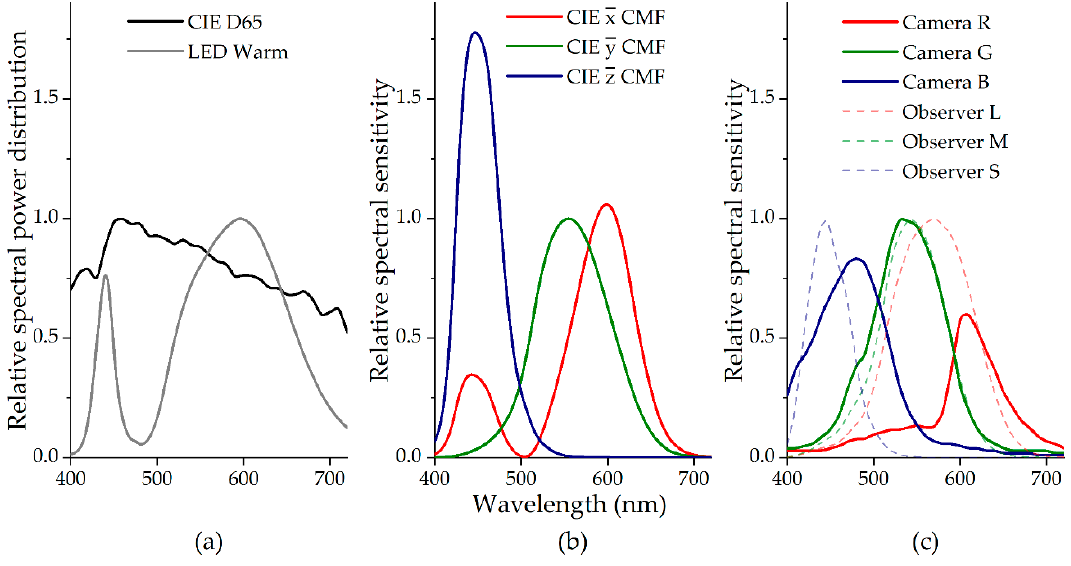
Figure 3. Relative spectral power distributions of the illuminants used ( a ), the CIE 1931 Observer color matching functions ( b ) and the digital camera sensor sensitivity ( c ), compared with the human cones sensitivity (dashed lines).